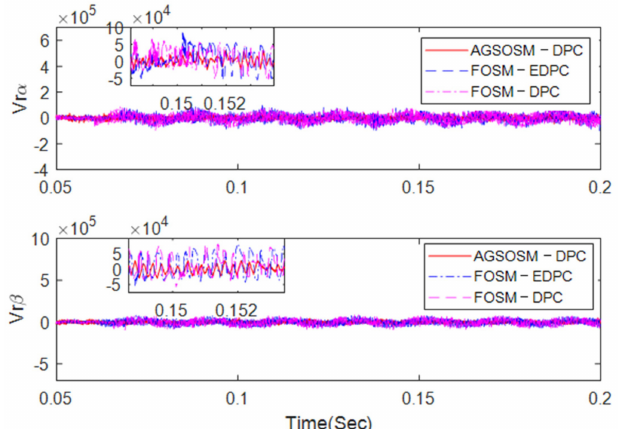
Figure 10. Stator current under unbalanced grid voltage.